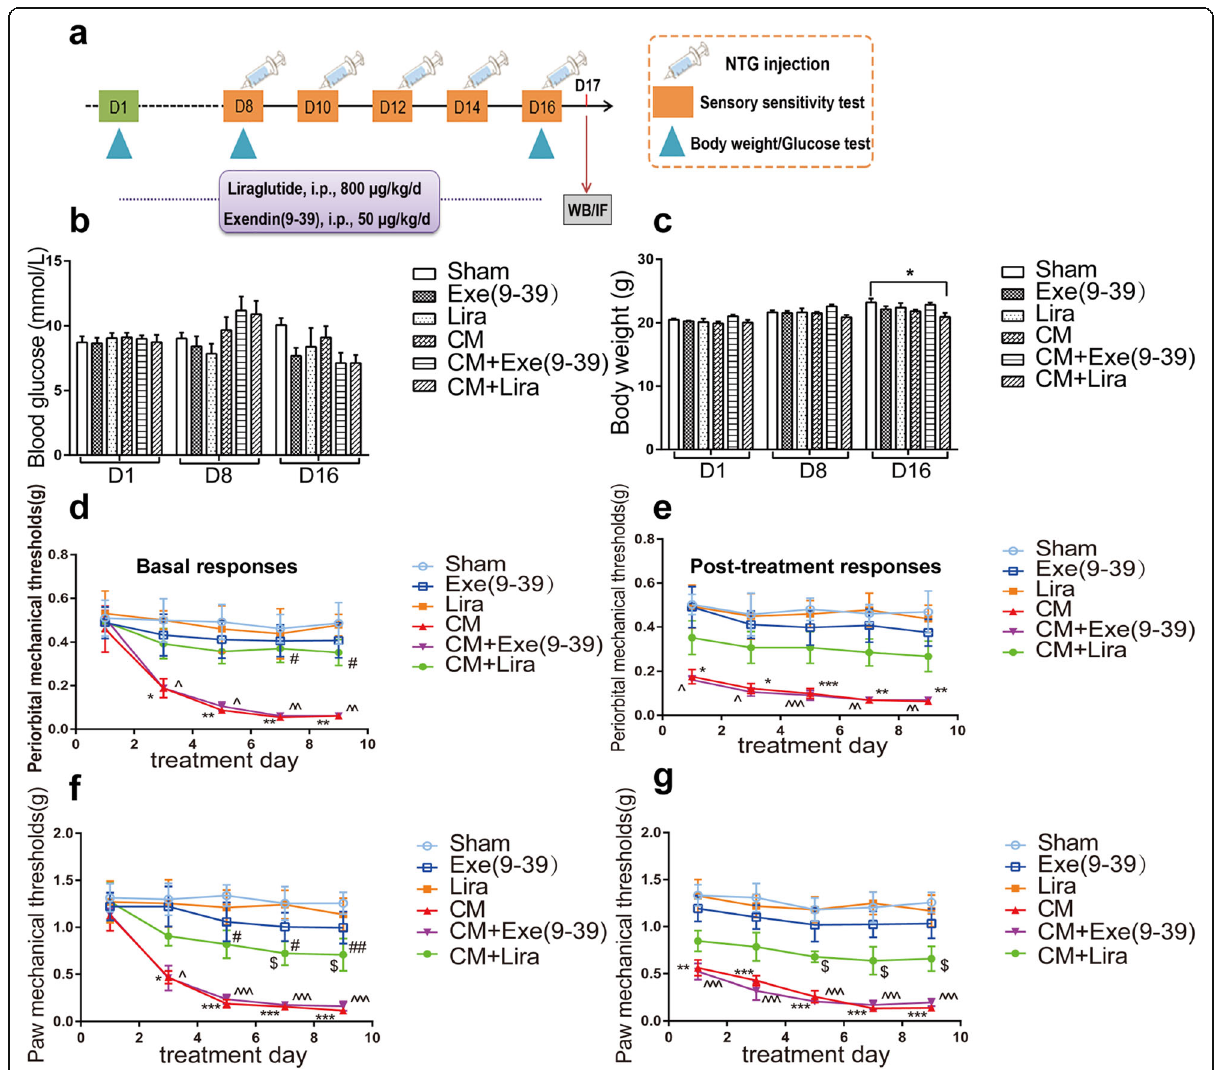
Fig. 3 Effect of GLP-1R on the glucose level, body weight, and mechanical hyperalgesia of CM mice. a The schematic of experimental outline. b, c The graph shows the effect of liraglutide and exendin(9 – 39) on random blood glucose ( b ) and body weight ( c ). The results showed that chronic liraglutide treatment decreased the body weight of CM mice compared with that of the sham group. There were no differences between various groups in terms of glucose concentration. Data are presented as mean ± SEM; n = 8/group; * p < 0.05 vs. sham group. d-g Repeated daily injection of liraglutide prevented basal periorbital ( d ) and hindpaw ( f ) mechanical allodynia. Post-treatment responses, including periorbital ( e ) and hindpaw ( g ) mechanical hyperalgesia, were assessed 2 h after NTG administration. Liraglutide did not significantly attenuate NTG-triggered acute hyperalgesia. Data are presented as mean ± SEM; n = 8/group; two-way ANOVA and Bonferroni post hoc analysis; *,^,$ p < 0.05, **,^^ p < 0.01 and ***,^^^ p < 0.001 CM, CM + Exe(9 – 39), CM + Lira groups, respectively, vs. sham group; # p < 0.05 and ## p < 0.01 CM + Lira group vs. CM group. Exe(9 – 39), exendin(9 – 39); Lira,